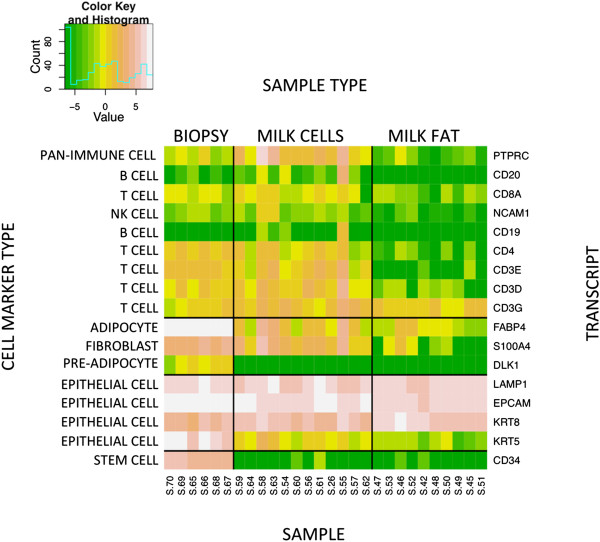
Expression of cell-specific markers in milk and mammary transcriptomes. Each box in the heatmap represents log-transformed expression intensity. The color key indicates the level of expression: Green = low/no expression, Yellow = low expression, Orange = moderate expression, Pink = high expression, and White = very high expression. The color key also includes a light blue line that indicates the number of observations at each level of expression.